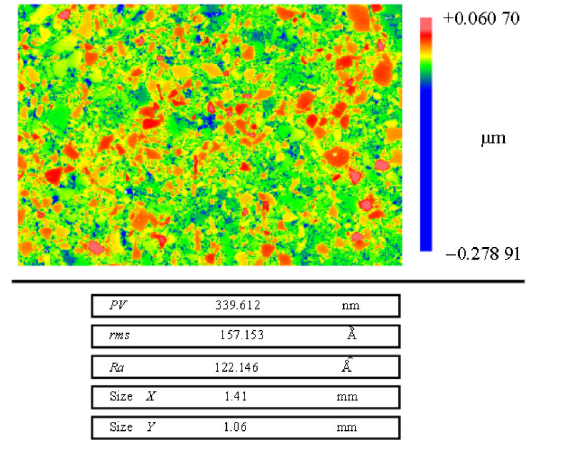
Fig. 12 RB-SiC roughness for 150-RPM orbital motion under 1.47-psi polishing pressure P .